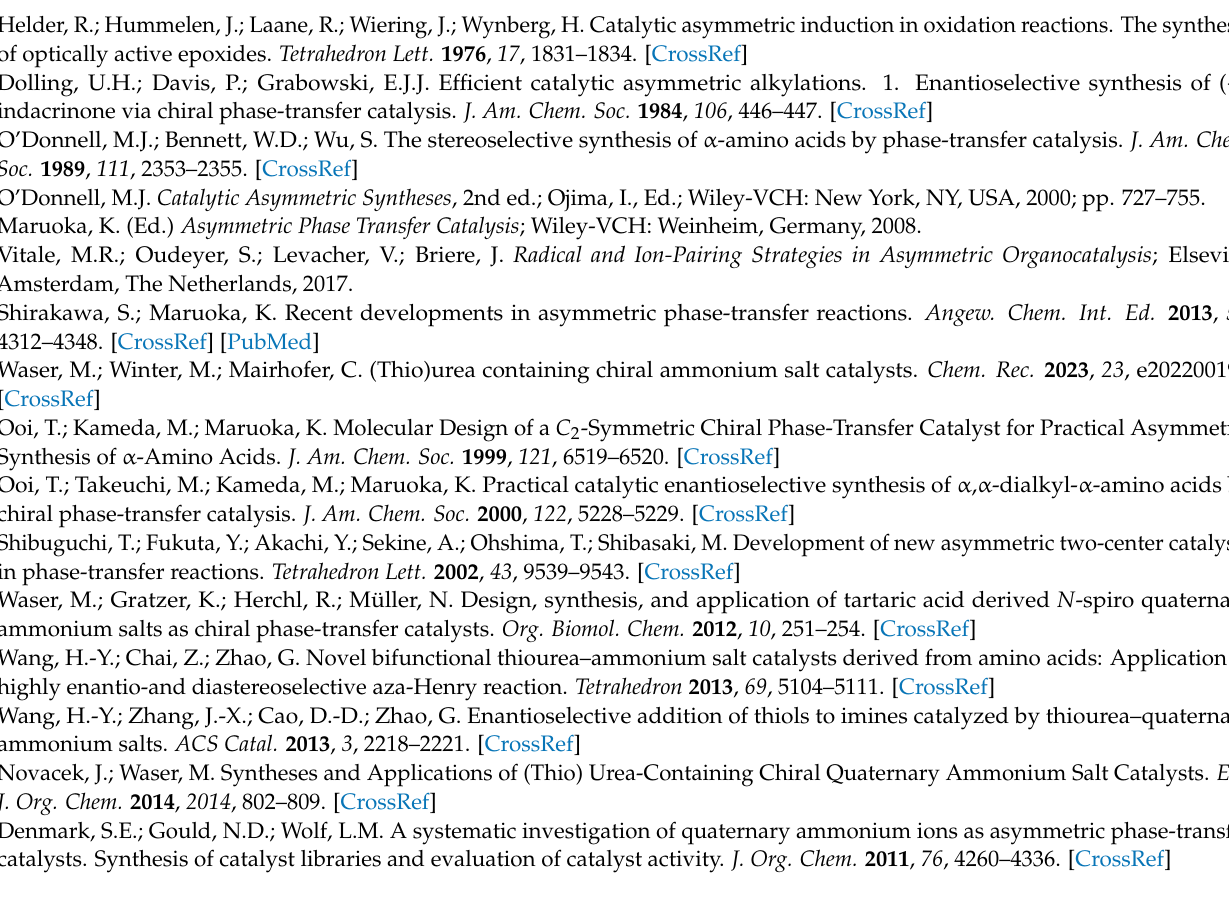
lysts I – IX in the fluorination of β -keto ester 9 . Table S2. Further evaluation of organocatalysts III , VIII , and IX in the fluorination of β -keto ester 9 . Table S3. Evaluation of organocatalysts II , III , VI – VIII , and IX in the chlorination of β -keto ester 9 . Table S4. Evaluation of organocatalysts III , IV , VII , VIII , and IX in the hydroxylation of β -keto ester 9 . Table S5. Evaluation of organocatalysts IV , VIII , and IX in the addition of β -keto ester 9 to tosylaziridine 14 . Table S6. Evaluation of organocatalysts I , III – V , VII , VIII , and IX in the addition of tert -butyl 2-((diphenylmethylene)amino)acetate ( 16 ) to methyl acrylate ( 17 ). Table S7. Correlation between the multiplicity of the H–C(3)- endo proton (He) and the endo absolute configuration at the C-2 chiral center of compounds 1a , 3b , 5a , 7a , b , and III – X . Table S8. Crystal data and structure refinement for compound VI-Br . Table S9. Crystal data and structure refinement for compound III